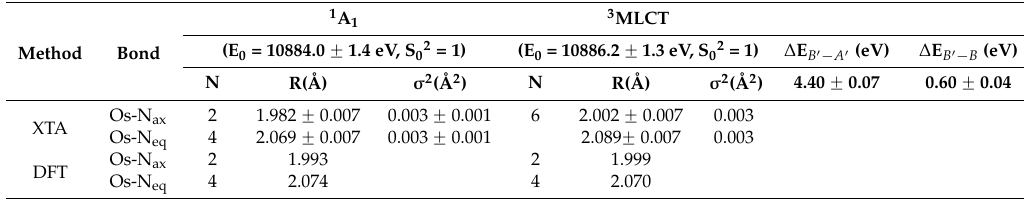
Figure 3. ( a , b ) Os L III —edge EXAFS oscillation, weighted by k 3 , where k is the photoelectron wavevector for the 1 A 1 state (black) and the 3 MLCT excited state (red) in ( a ) k space and in ( b ) R space; ( c , d ) Magnitude (green dots) and imaginary (blue dots) parts of the Fourier transform of the k 3 weighted EXAFS oscillations, along with their best fits (green and blue solid lines respectively) to the model described in the text; for ( c ) the 1 A 1 state and for ( d ) the 3 MLCT excited state. It should be noted that these spectra are phase uncorrected, so that the distance R of the maximum distribution are actually smaller than the actual experimental average Os-N bond lengths for both states. Table 1. Electronic and structural parameters of [Os(terpy) 2 ] 2+ in ground and 3 MLCT states solvated in methanol, as determined by XTA and DFT calculations. The values that were kept fixed during the fitting procedure are indicated in italic.